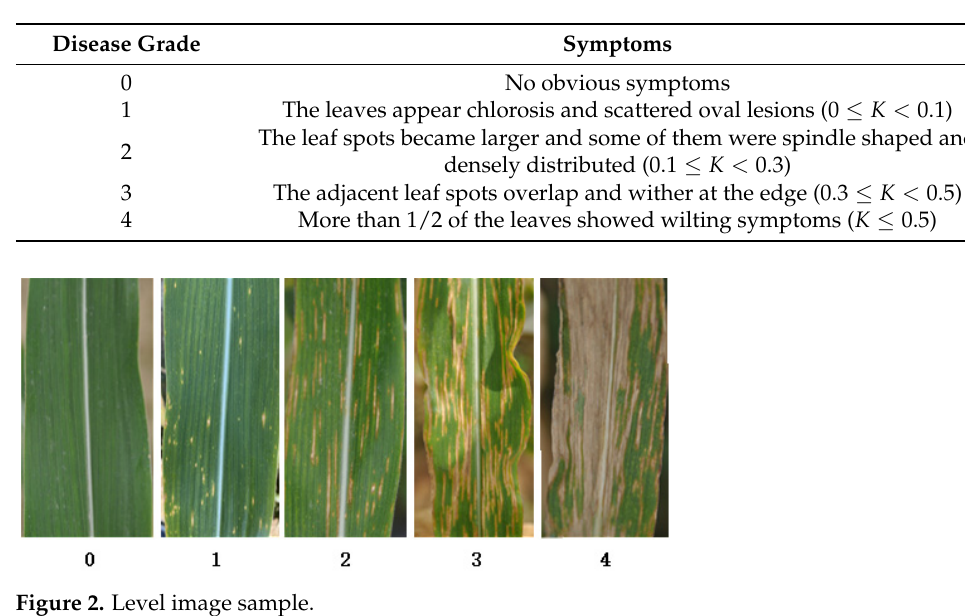
Table 1. Disease classification standard.